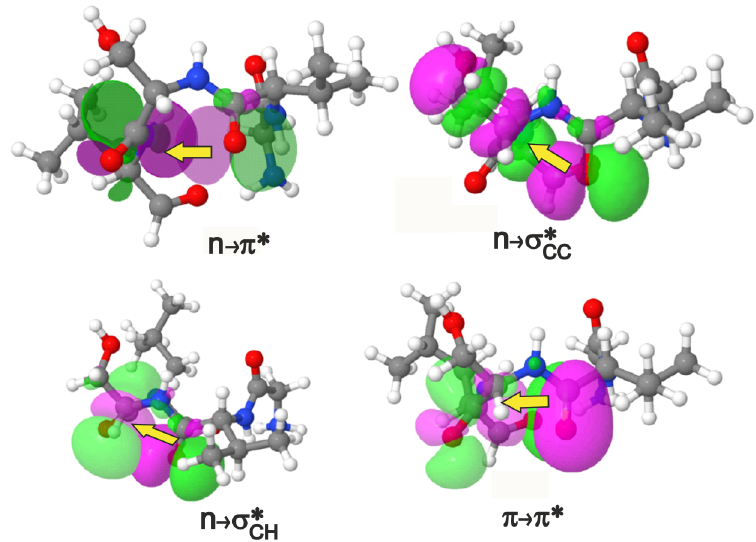
Figure 2. The n → π ∗ , n → σ ∗ (2 types) and π → π ∗ interactions shown in terms of donor-acceptor orbital overlaps in a view where the i + 1– i + 2 residues project out of the plane of the paper towards the reader. An isovalue of 0.02 e/Å 3 was used in the plots. The i + 1– i + 2 pairs shown above are valine-serine for the depiction of n → π ∗ , n → σ ∗ and π → π ∗ , and valine-threonine for n → σ ∗ . CH CC The magenta/green stand for opposite phases of the orbital wavefunction. If we choose to assign positive values to the magenta lobe of the orbital in that region of 3D space, then the green lobe represents negative values of the same orbital and vice